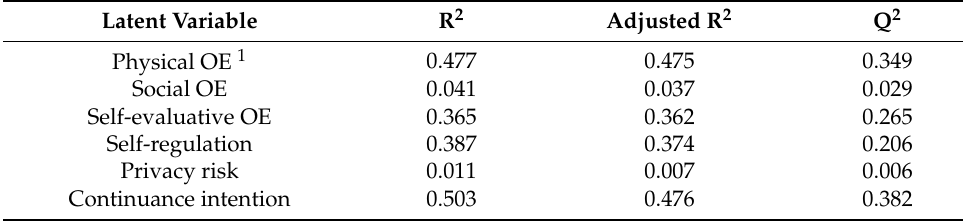
Table 4. The R 2 and Q 2 values of endogenous